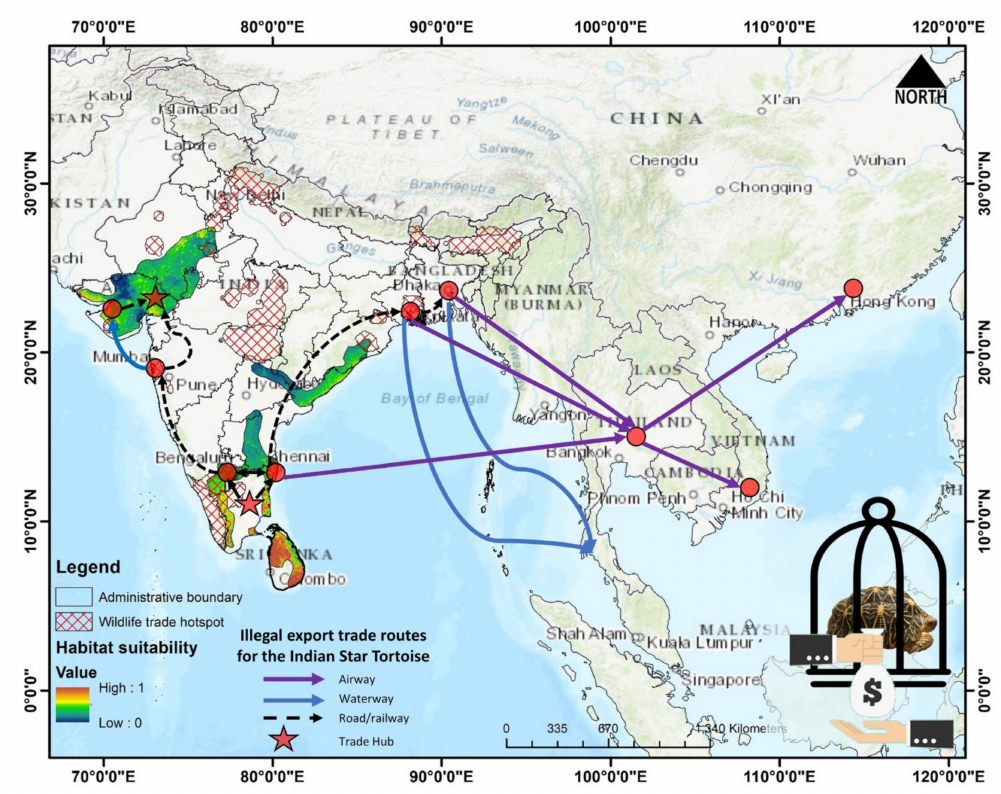
Figure 6. Comparative visualization of the suitable ranges for G. elegans , along with illegal wildlife trade hotspots (https://www.wpsi-india.org/crime_maps/trade_hotspots.php, accessed on 25 November 2022) and the domestic and international illegal export trade routes of G. elegans (D’Cruze et al., 2015). The species photograph was acquired from the free media repository Wikimedia